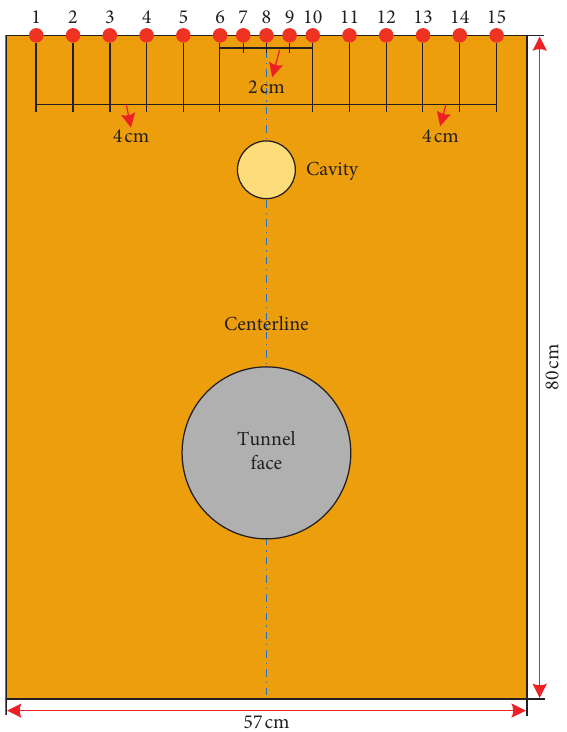
Figure 5: Ground displacement monitoring